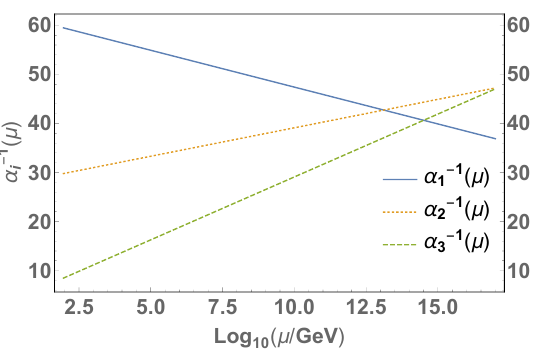
Figure 1 . SM Renormalization Group Evolution (RGE) of gauge couplings g i at 1-loop written in terms of (cid:11) i (cid:17) g 2 = 4 (cid:25) . The label \i = 1,2,3" denotes the U(1), SU(2) and SU(3) SM subgroups i p respectively with the normalization that g 1 = 5 = 3 g 0 where g 0 is the SM hypercharge coupling.